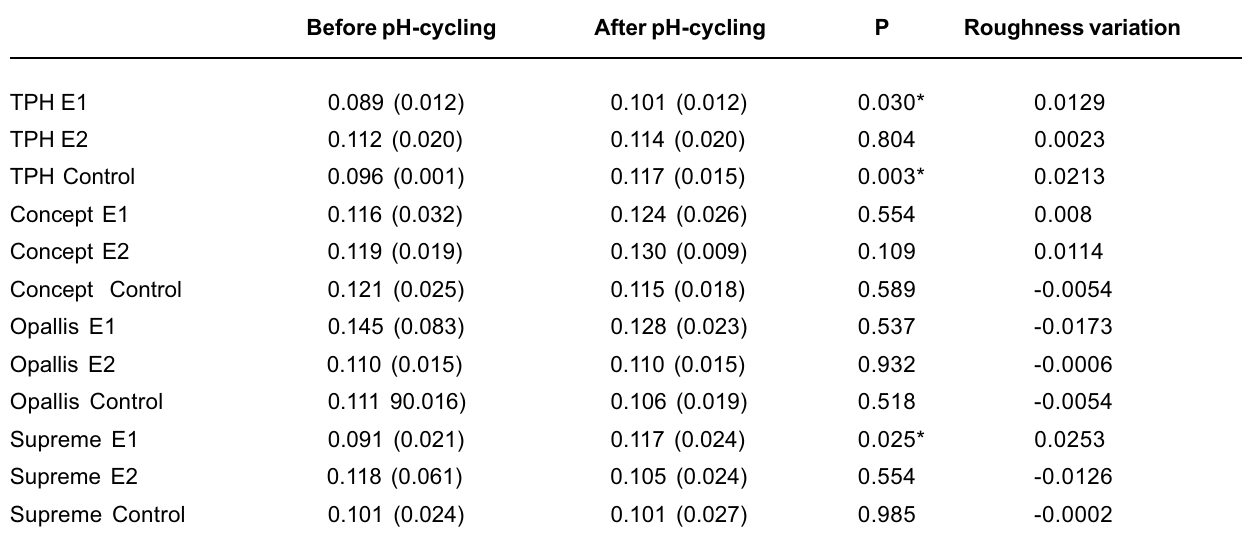
* Significant at α =